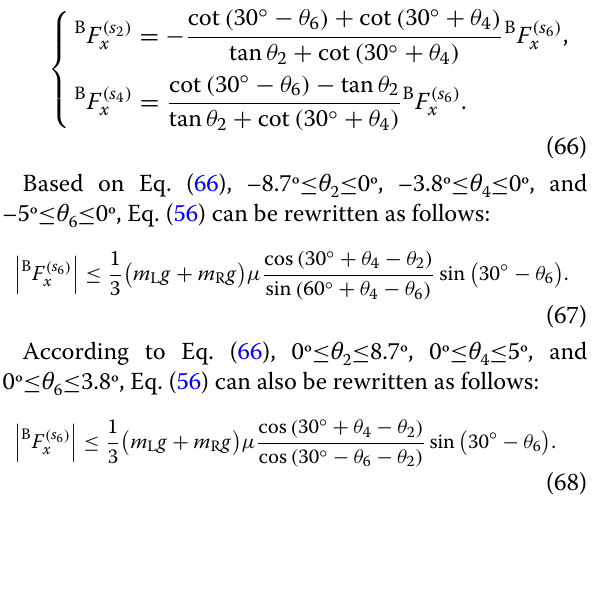
Table 2 Working conditions of variable values Working conditions Rotational angles of abductor joints under support phase